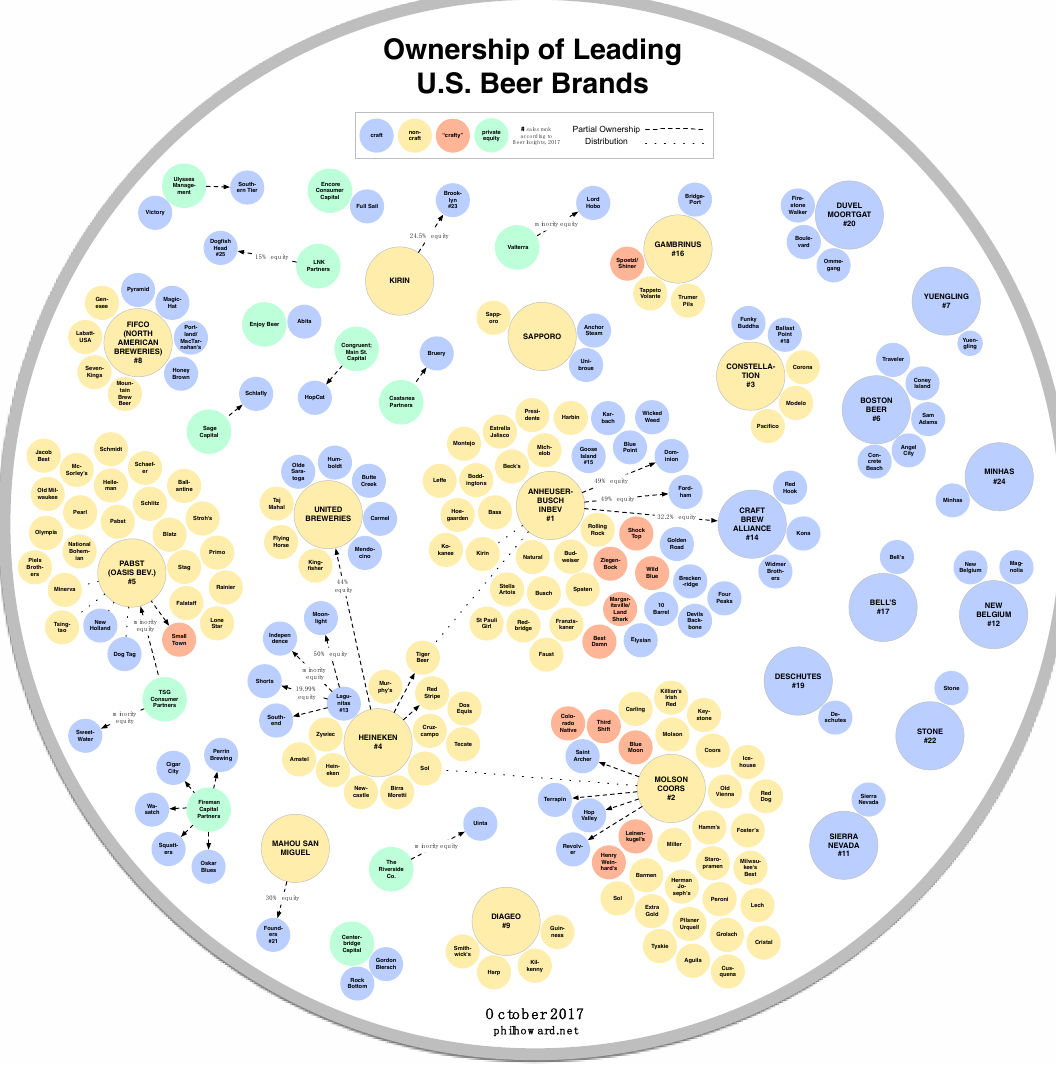
Figure 3. Ownership of leading U.S. beer brands.